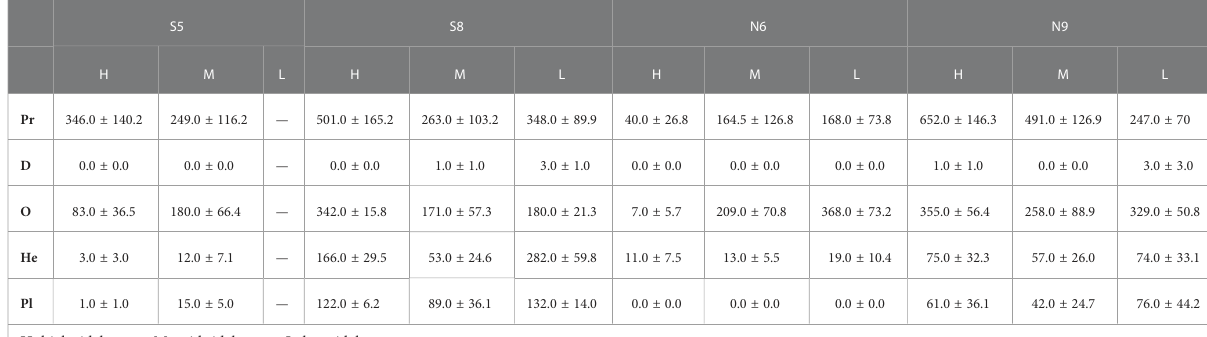
TABLE 3 Abundance of macrobenthos functional groups in the constructed intertidal oyster reef in Yangtze River Estuary during 2016-2017. S5 S8 N6